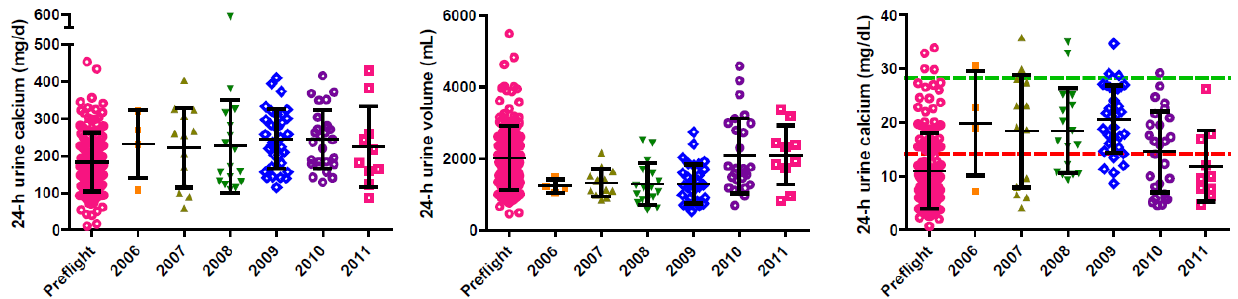
Figure 4. Urinary calcium excretion (left), urine volume (middle), and urinary calcium concentration (right) before and during flight, by year of collection on the ISS. Each symbol represents a 24-h urine collection; 23 crewmembers may have each provided up to five 24-h collections during flight, and at least 4 before flight. Within data sets, the horizontal lines represent the mean ± 1 SD. The green dashed line in the right panel represents a calcium concentration of 28.3 mg/dL, the expected calcium precipitation point for UPA water recovery at 70%, and the red dashed line represents calcium concentrations of 14.2 mg/dL, the expected calcium precipitation point for UPA water recovery at 85%. A subset of these data, in a different form, have been published, along with details of urine collection procedures